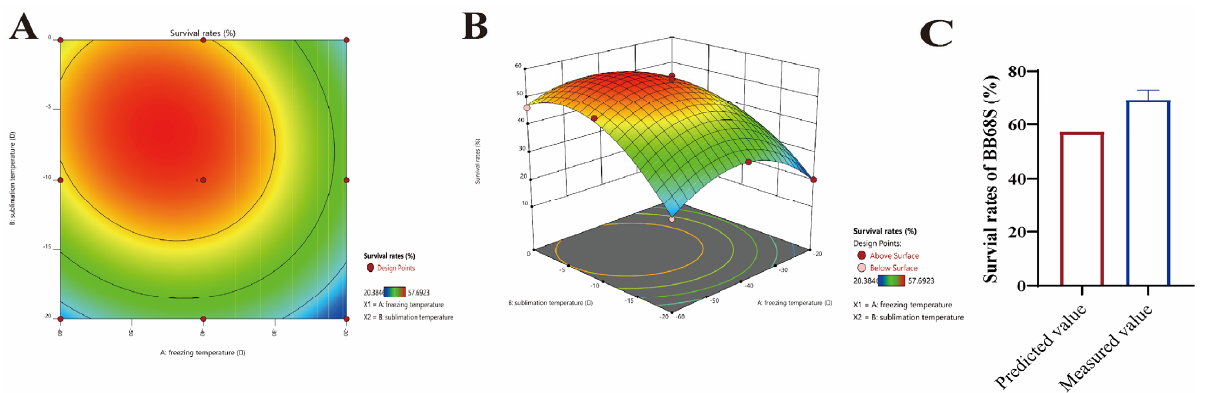
Figure 2. Effects of pre − freezing temperature and sublimation temperature on the survival rates of Bifidobacterium longum BB68S after freeze-drying process. ( A ) Contour; ( B ) 3D Surface; ( C ) Predicted values and measured values for survival rates of BB68S under optimal